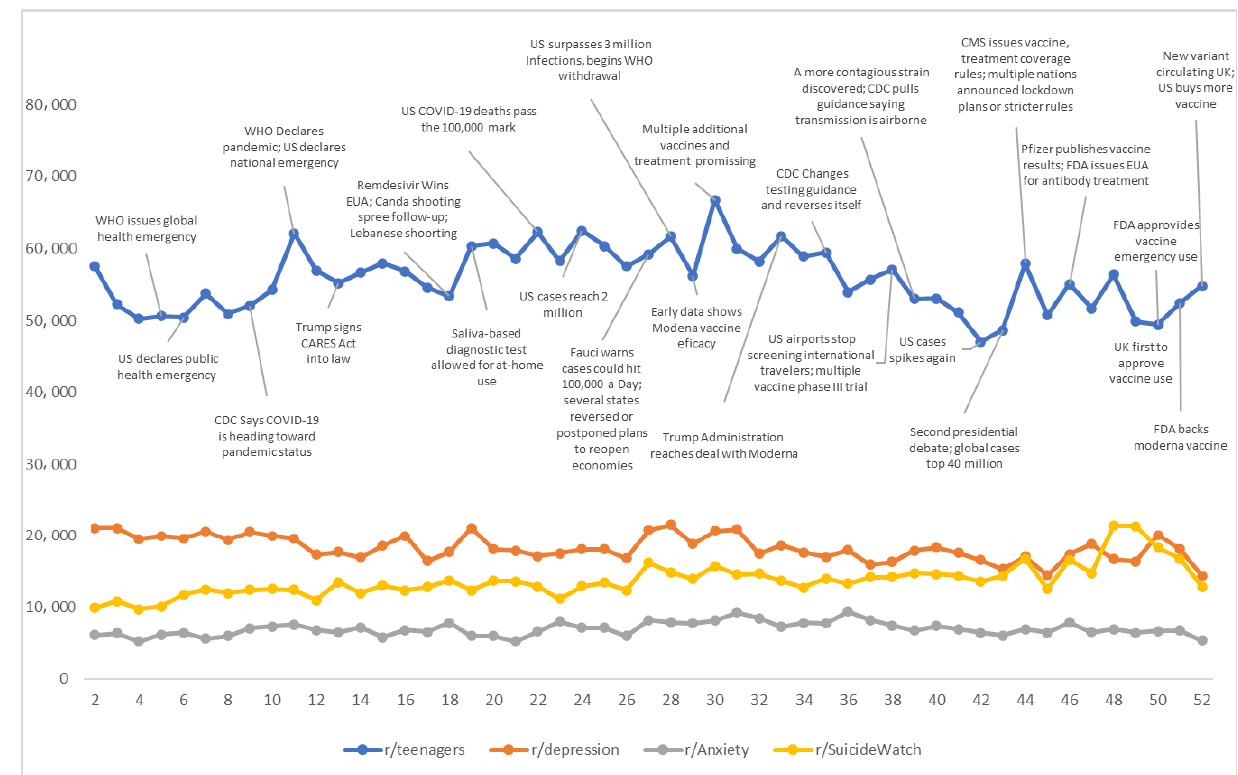
Figure 1. Weekly total number of active participants by subreddits. Note. The first and last weeks were excluded because of incomplete weekdays. The numbers of participants for the three mental health subreddits (r/Depression, r/Anxiety, and r/SuiscideWatch) were multiplied 30